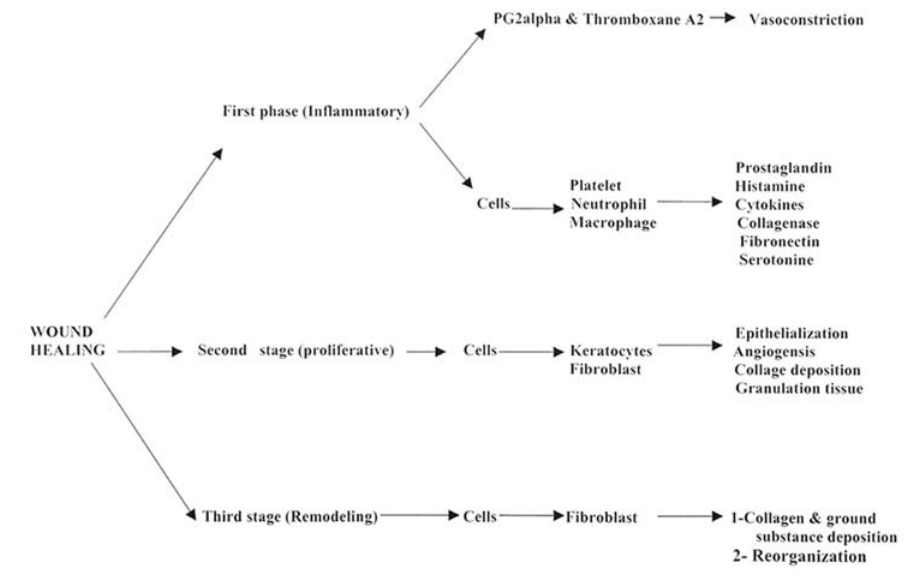
FIGURE 2 . Stages of wound healing and cellular involvement.